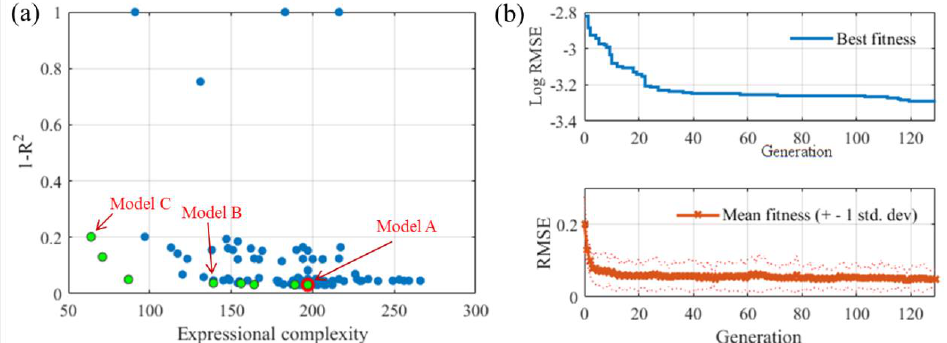
Figure 3. The Pareto front plot of the evolved MGGP-based models and convergence of the solutions: ( a ) Pareto front plot; and ( b ) convergence of the solutions.